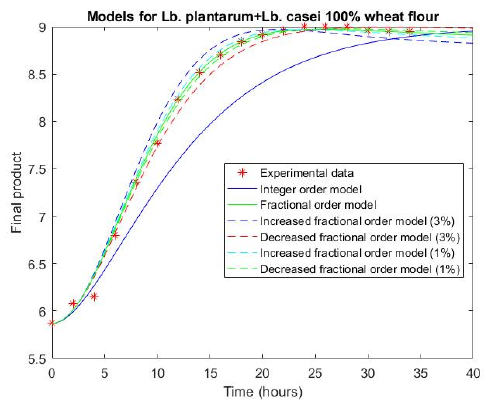
Figure 7. Comparison between simulated and experimental data for experiment 1 using both types of bacteria.